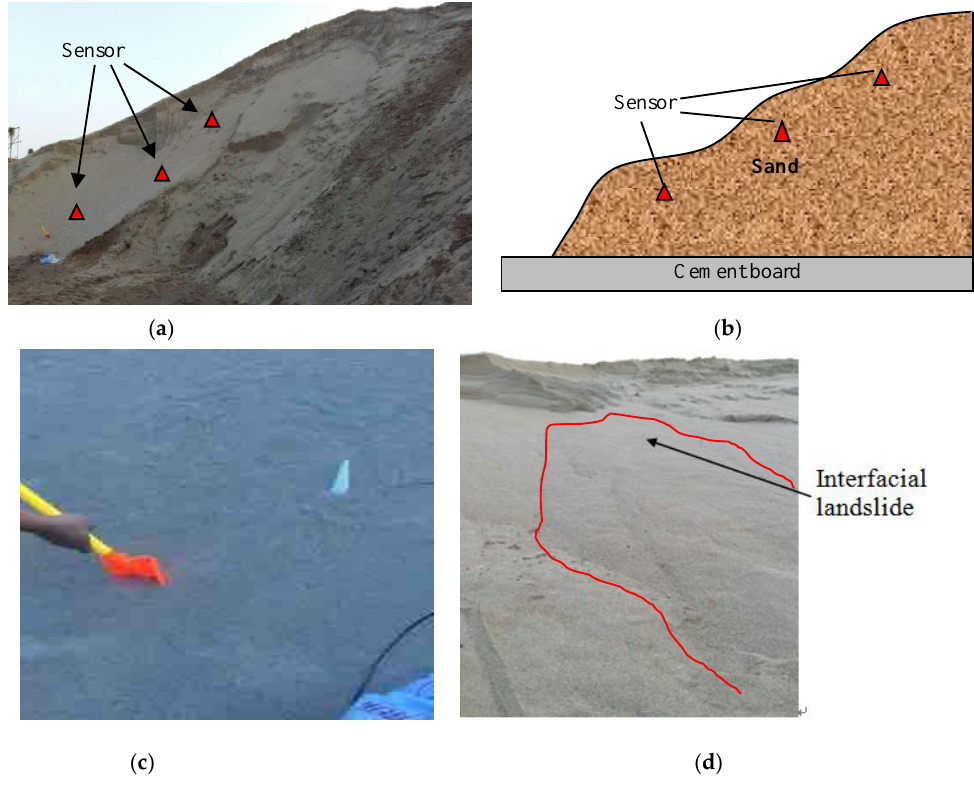
Figure 11. Experimental monitoring of sand interface slide by the sensor prototype. ( a ) The sand dune in field; ( b ) Schematic diagram of sand pile and sensor location; (c) Disturbance; (d)The sand interface slide due to disturbance.